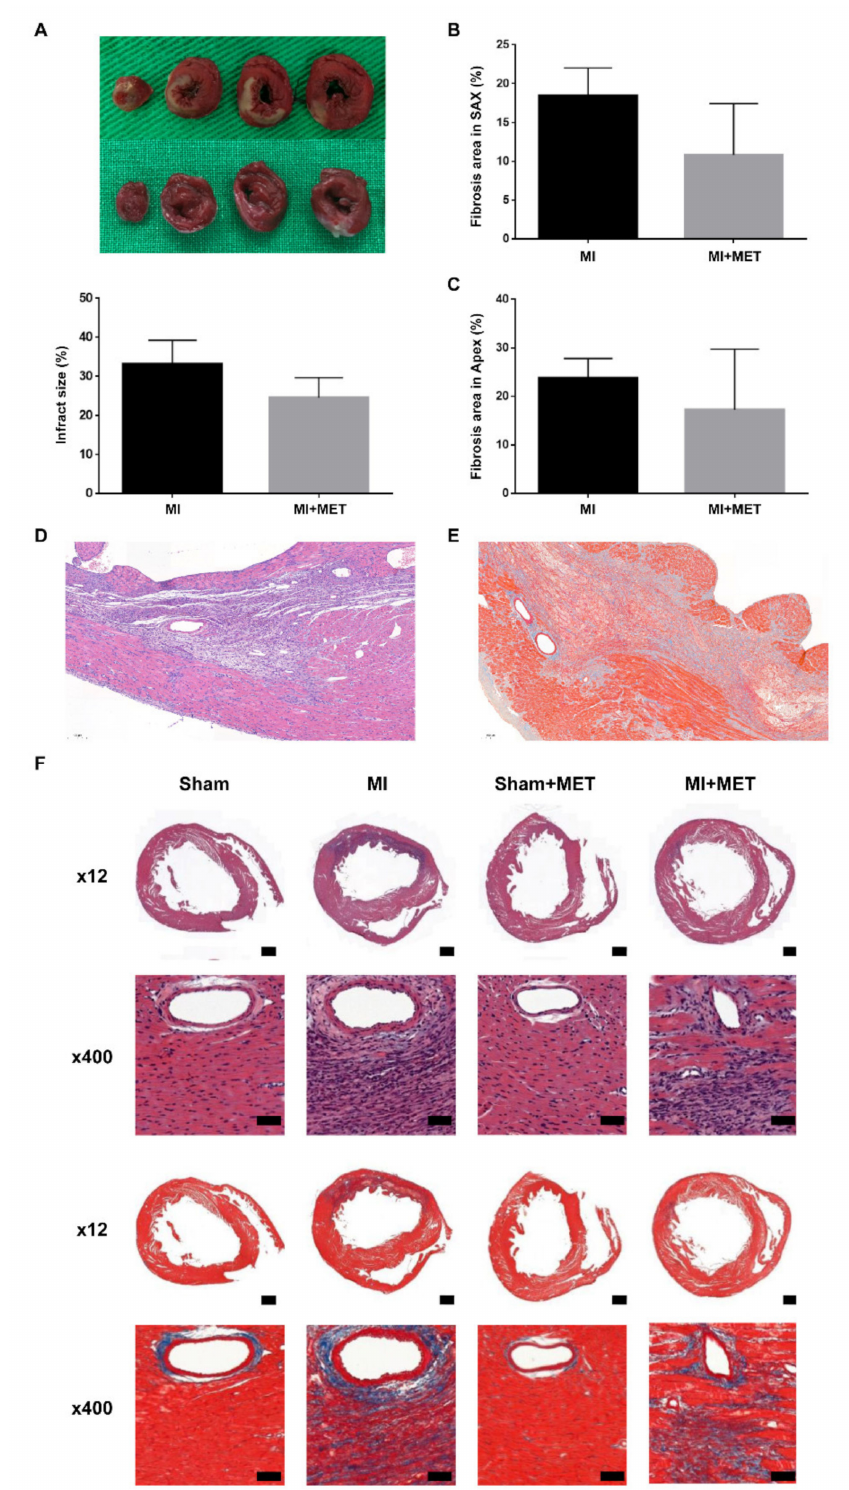
Figure 3. Protective e ff ect of metformin on infarct size and histopathological changes in the left ventricle of a rat. ( A ) Representative photogram of left ventricle slice and the infarct size; ( B – C ) degree of fibrosis (%) in the SAX (short-axis region with papillary muscle) and apex area ( n = 3 in both groups); and ( D – F ) hematoxylin and eosin and Masson’s trichrome staining on Day 7 ( D , E ,: × 100; F, scale bar: 1000 µ m, 50 µ